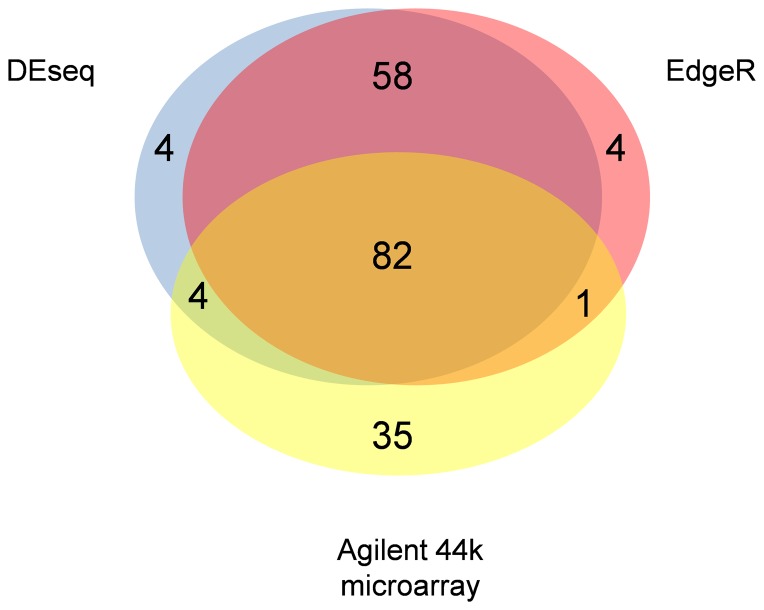
Venn diagram showing differentially expressed genes that were identified by mRNAseq coupled to the DEseq (blue) and EdgeR (red) packages; and Agilent 44k microarray hybridization (yellow).